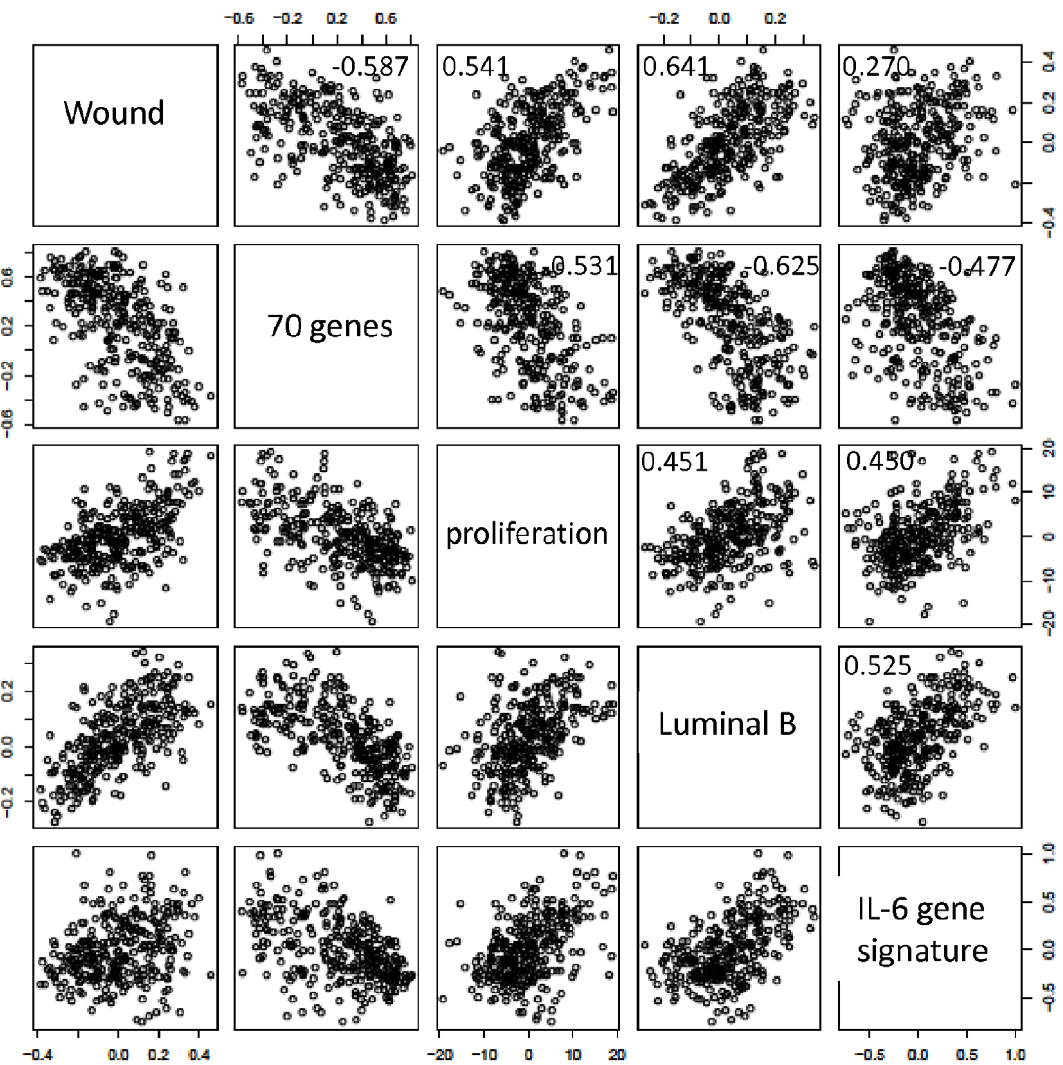
Figure 6. Correlations of the ‘‘IL-6 gene signature’’ with other published prognostic gene signatures in early stage breast cancer. Scatter plots showing the relationship between the value of the centroids of the ‘‘70-gene signature’’ [24], the ‘‘wound signature’’ [53], the ‘‘luminal type B signature’’ [26], the ‘‘proliferation’’ signature and the ‘‘IL-6 gene signature’’ in the NKI study. Each point in the scatter plots represents a single one of the 295 tumors analyzed in the NKI dataset. A 5 6 5 pair-wise scatter plot matrix of the five gene signatures is shown. Columns and rows are labeled in the diagonal panels, i.e. the first top right panel represents data for the centroids of the ‘‘Wound’’ signature plotted against the centroids of the ‘‘IL-6 gene signature’’. The overall correlation between each pair of expression signatures across this set of 295 samples is indicated in each